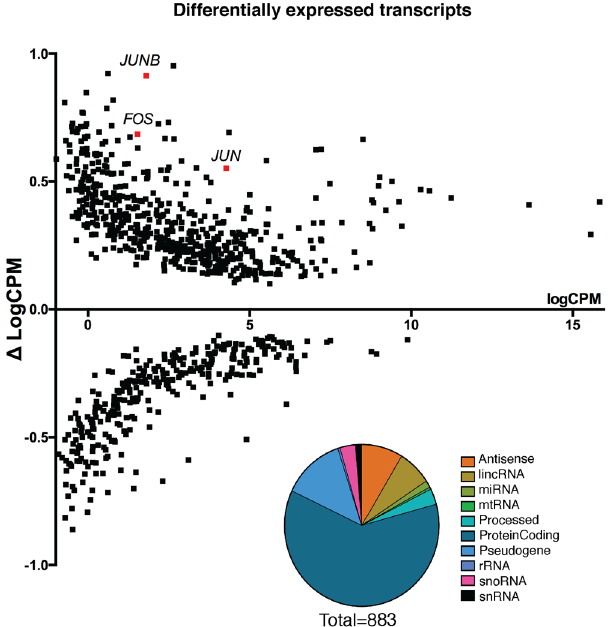
Figure 2. Differential expression of transcripts in human dlPFC between cocaine and control cases. We used Voom limma to identify 883 transcripts with a nominal p-value < 0.05. We observed up-regulation of c-FOS and c-JUN transcription factors, shown in red, which are immediate early genes known to play a role in transcriptional alterations underlying neuronal plasticity. ( c-FOS : p < 0.02; c-JUN : p < 0.01; JUND : p < 0.01). Y-axis is delta of logCPM = ([logCPM Avg. Cocaine] − [logCPM Avg. Control]) and denotes up- or down- regulation of transcription. (Inset) Quantification of types of 883 transcripts with p < 0.05.